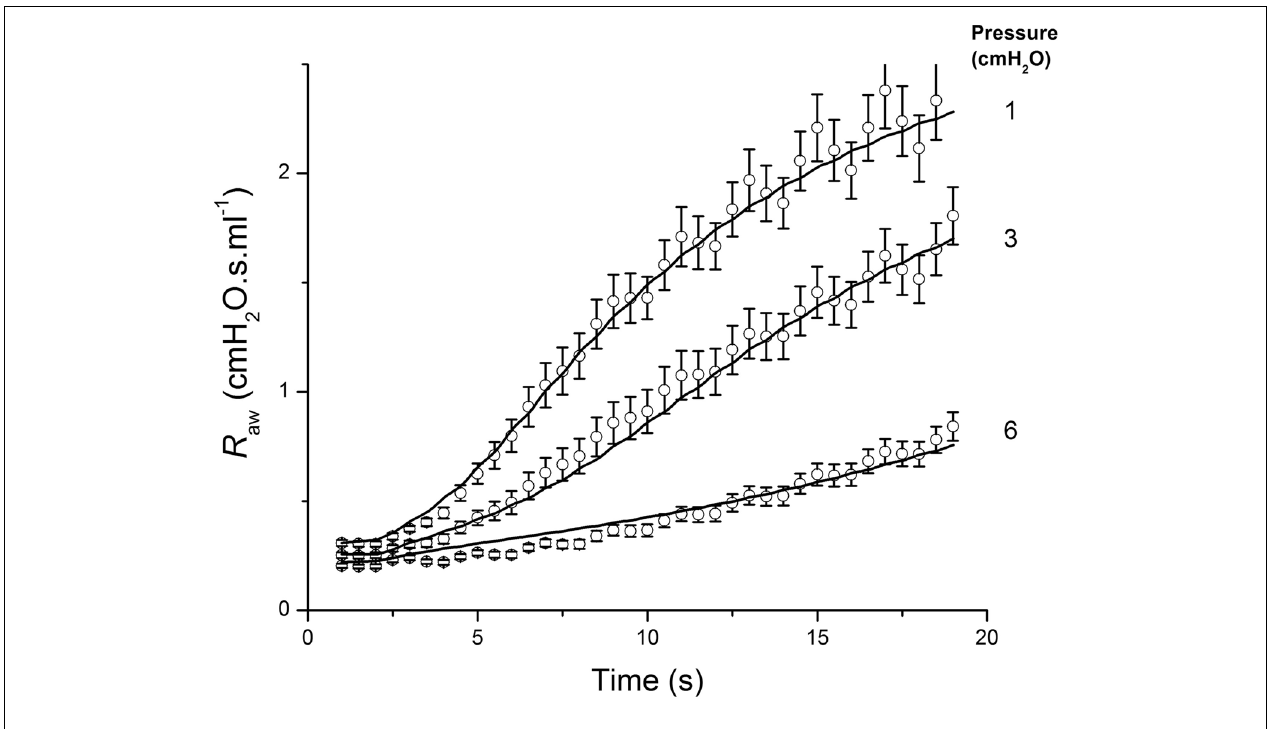
figure. The solid line shows the fit provided by a computational model of an elastic airway embedded in parenchyma that contracts according to a hyperbolic force-velocity relationship. Adapted from Cojocaru et al.